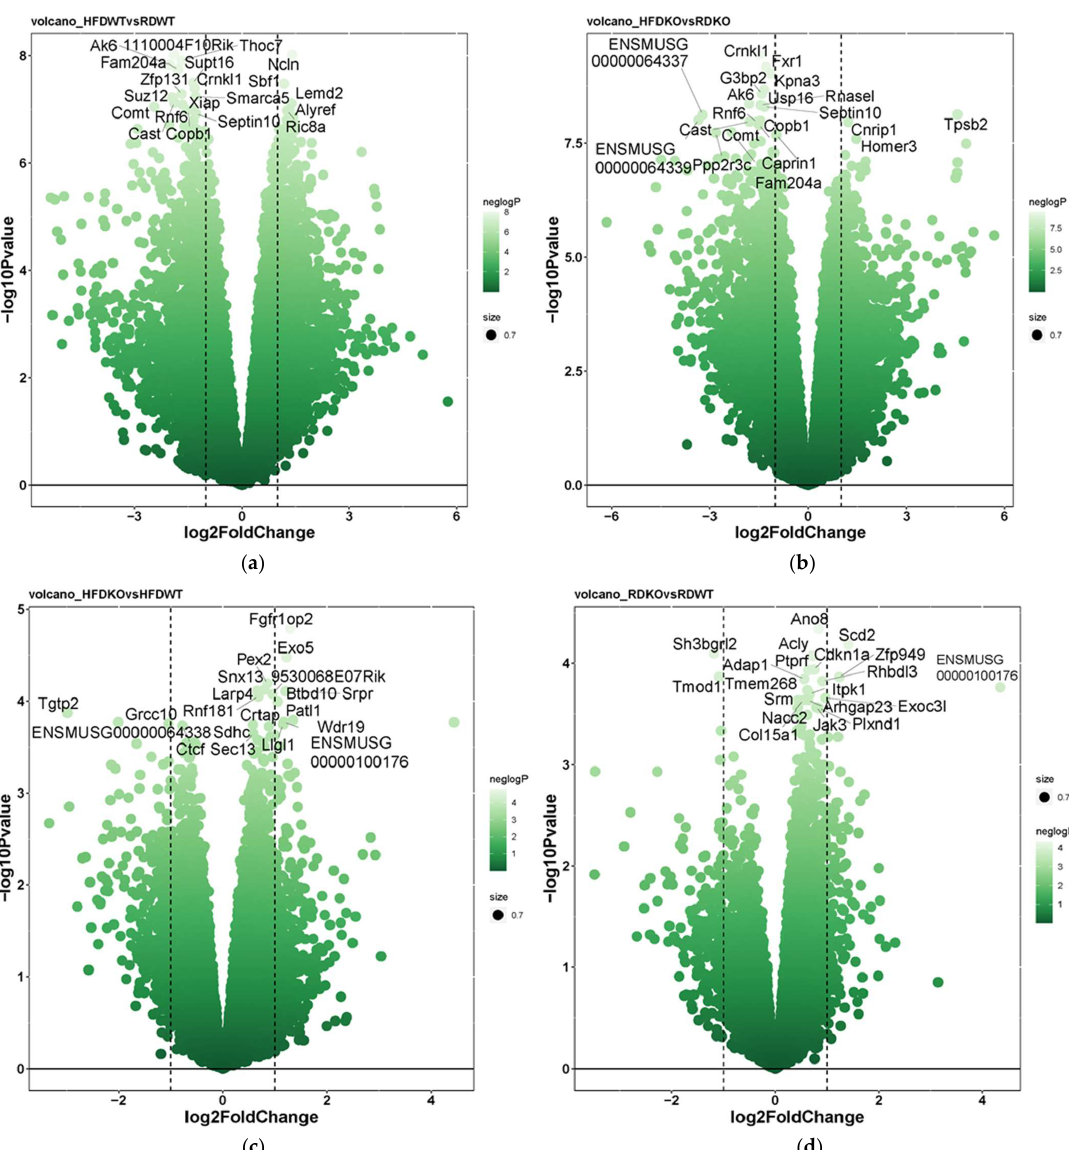
Figure 7. Volcano plots depicting differential eWAT expression patterns across diet (chow or HFD) or genotype ( Lama4 fl/fl mice or Lama4 AKO ) comparisons. ( a ) High-fat vs. chow diet comparison in Lama4 fl/fl mice; ( b ) High-fat vs. chow diet comparison in Lama4 AKO mice; ( c ) Lama4 fl/fl mice vs. Lama4 AKO mice on a high-fat diet; ( d ) Lama4 fl/fl mice vs. Lama4 AKO mice on chow diet. RD = chow diet, HFD = high-fat diet, WT = Lama4 fl/fl and KO = Lama4 AKO . The top 20 differentially expressed genes are annotated in each volcano plot, with full gene names appearing in Appendix B. Dashed lines represent the significance cutoffs for identifying genes as significantly regulated. We next investigated the extent of overlap among the differentially expressed genes from each comparison (Figure 8) and found 887 genes to be regulated in common in re- sponse to diet between Lama4 fl/fl and Lama4 AKO mice. In contrast, there was almost no over- lap between Lama4 fl/fl and Lama4 AKO mice on chow or HFD. A group of 45 genes was found to be differentially expressed in common between HFD-fed Lama4 fl/fl and Lama4 AKO mice, as well as between HFD and chow-fed control mice (Figure 8). These genes spanned var- ious biological functions including peroxisomal and ribosomal function, protein targeting, protein regulation, RNA regulation, and DNA damage (Supplementary Table S1). A de- tailed analysis of the direction of expression of these 45 genes showed both HFD-fed Lama4 AKO mice and chow-fed Lama4 fl/fl mice to display similar changes in gene expression compared to HFD-fed Lama4 fl/fl mice, suggesting that adipocyte LAMA4 loss under HFD conditions mimics a transcriptomic phenotype similar to that of chow-fed control animals. The expression changes of the top 10 genes in this category (selection based on averaged p-values across the comparisons) are shown in Figure 9 (expression profiles of all 45 genes shown in Supplementary Figure S4a,b).